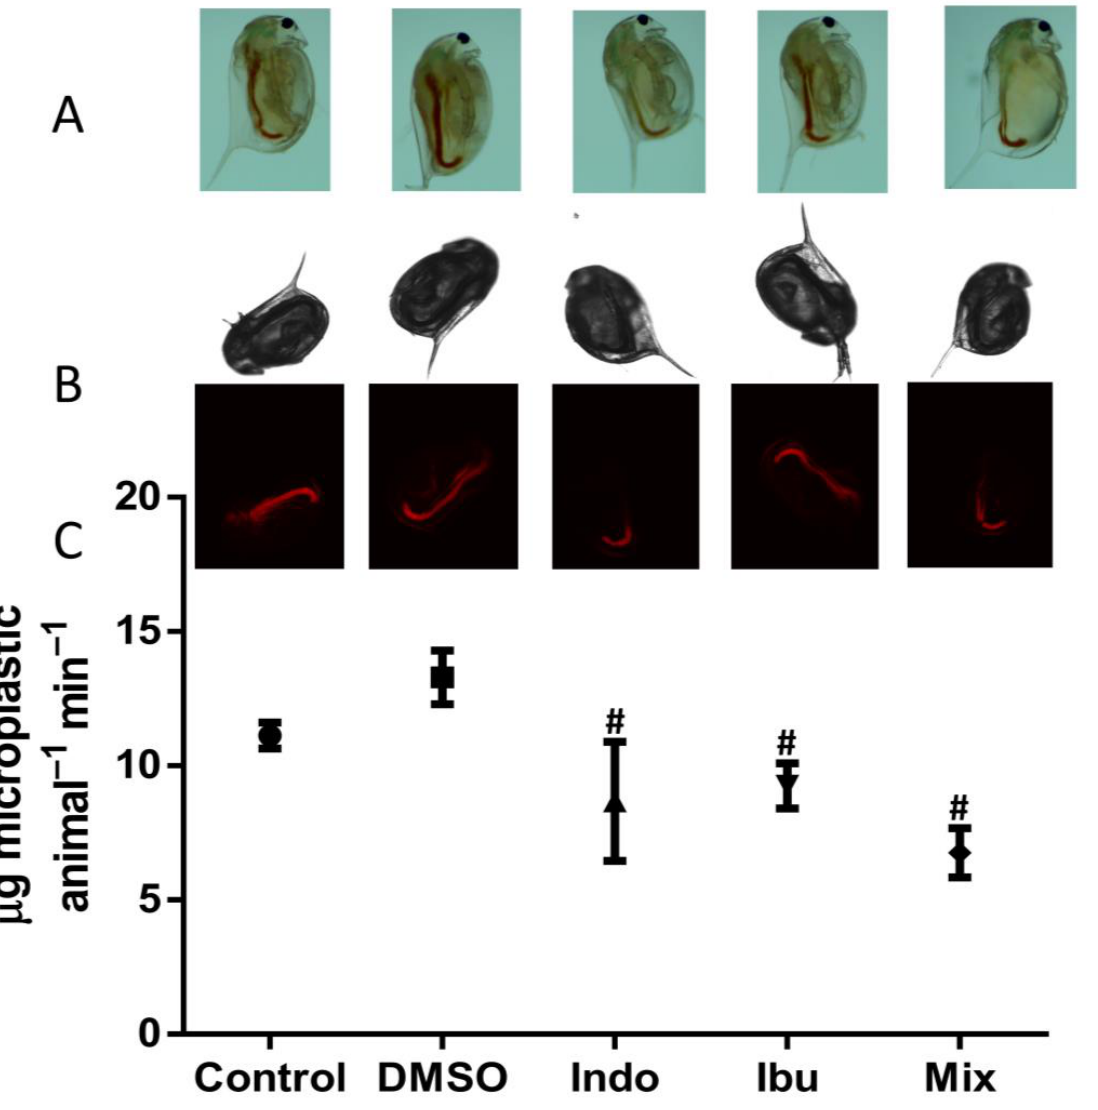
Figure 3. The impact of NSAIDs on feeding rate to neonates. The ingested microparticles were visualized by optical stereoscopy ( Panel A ), bright field, and fluorescence microscopy ( Panel B ). Feeding rate was quantified by the ingestion of microparticles based on their fluorescence in the incubation media ( Panel C ). Data represent average ± standard deviation (N = 5 replicates). # Statistically significant by Student’s t -test denotes significant difference in comparison to the DMSO carrier sol- vent.